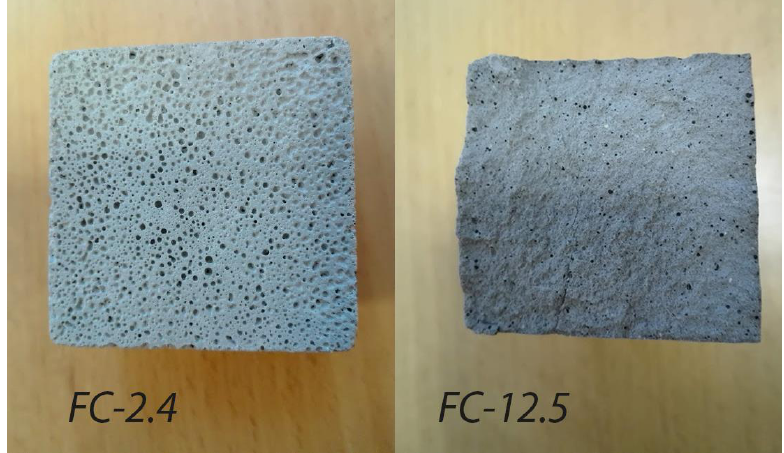
Fig. 1. Foam concrete FC-2.4 and FC-12.5. T ABLE 1. F OAM C ONCRETE C OMPOSITIONS FC-12.5 AND FC-2.4 FOR 1 M